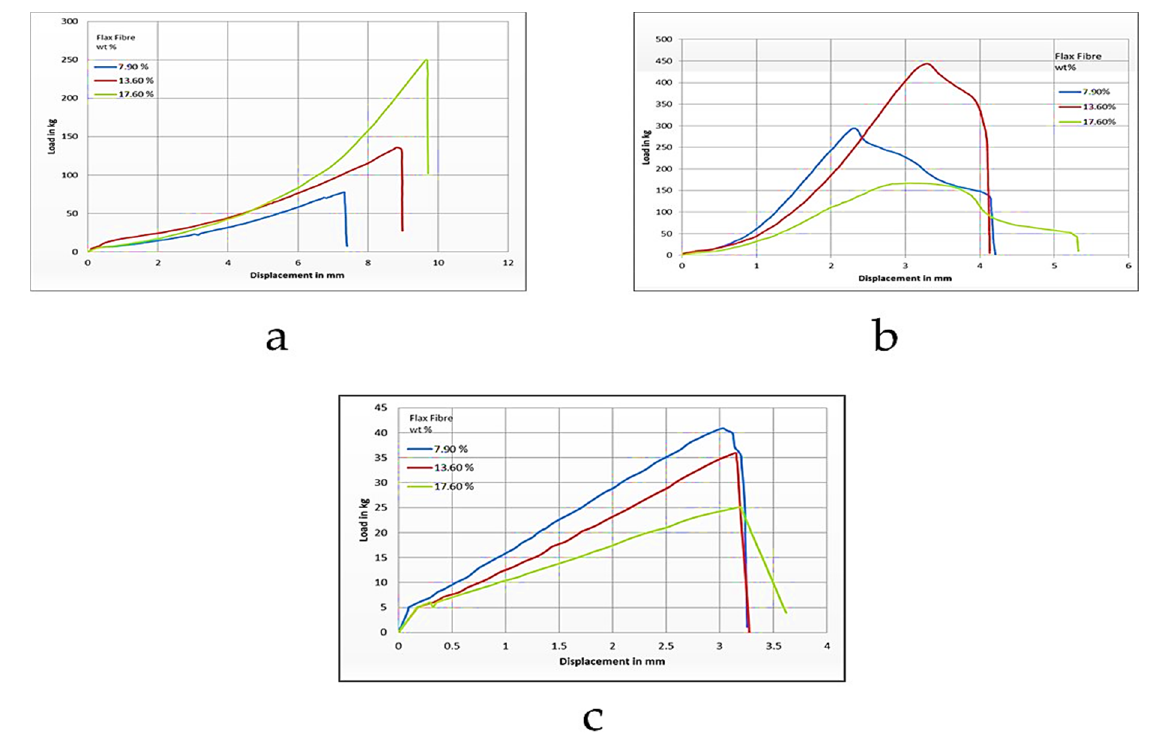
Figure 12. Loading versus displacement graphs from: ( a ) tensile test; ( b ) compression test; and ( c ) bending test. Reproduced with permission from [305].